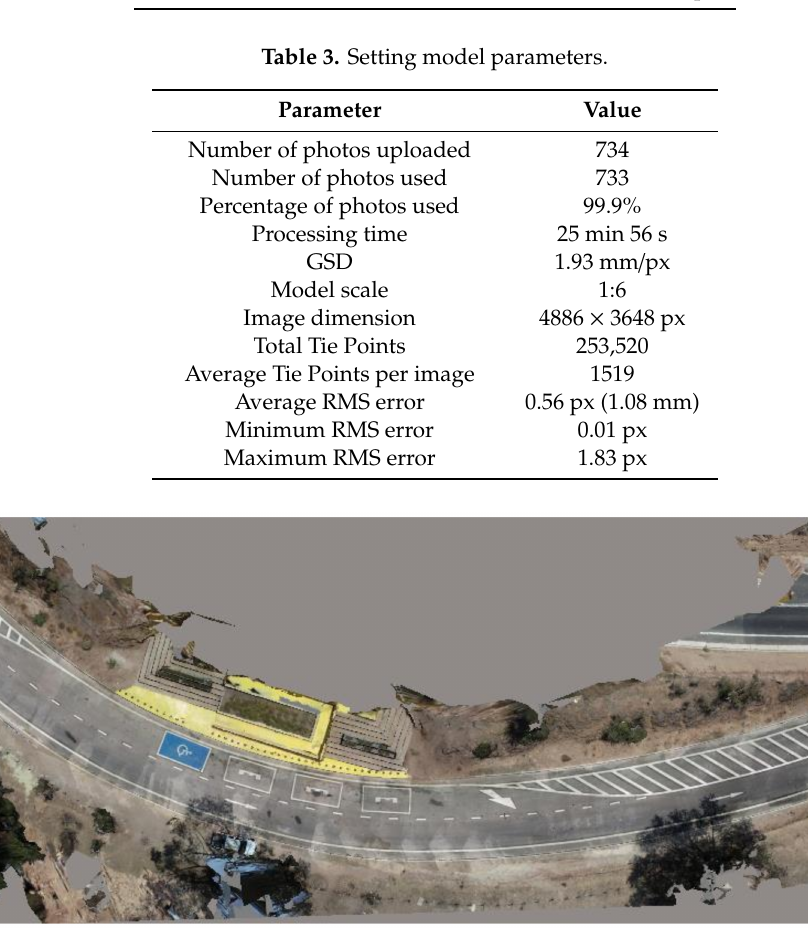
Figure 4. Virtual model “MIRADOR1” generated in Context